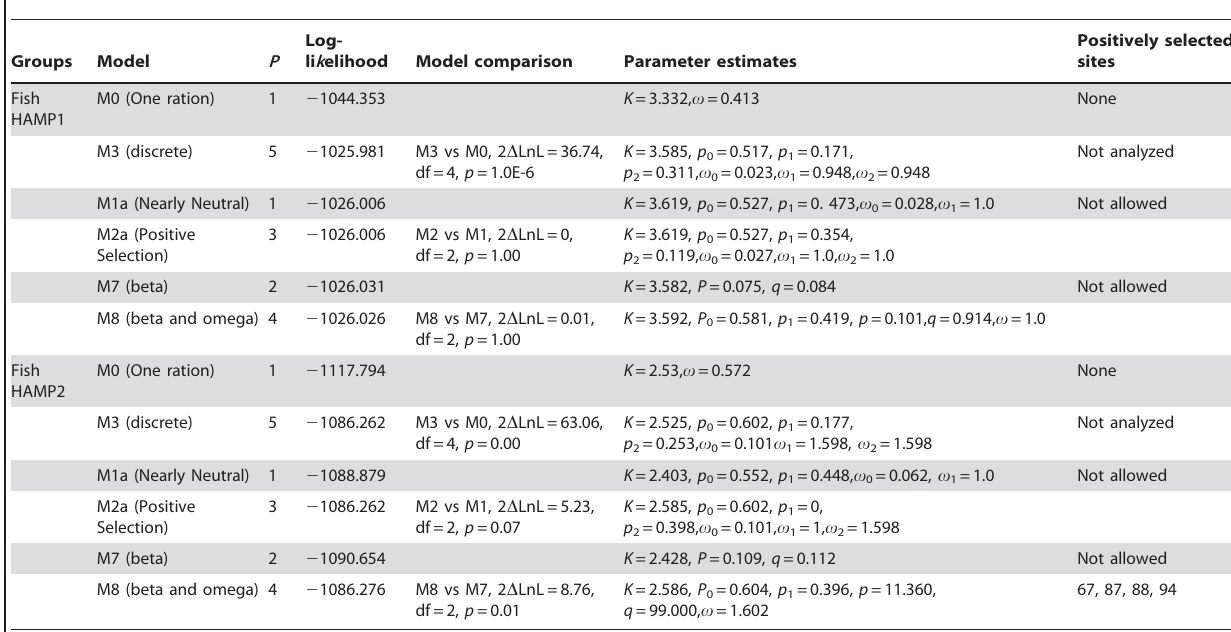
Table 1. Evidence of positive Darwinian selection from site-specific model analyses for the HAMP gene of fish.